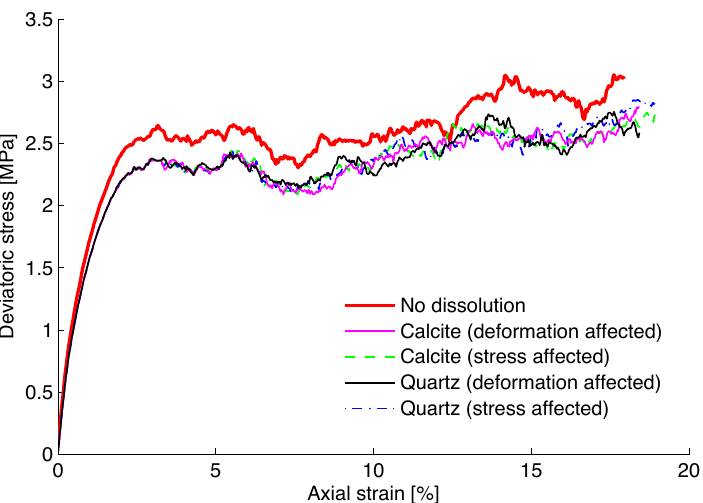
Figure 3. Simulation of the stress–strain responses of quartz and calcite assemblies subjected to dissolution during loading.